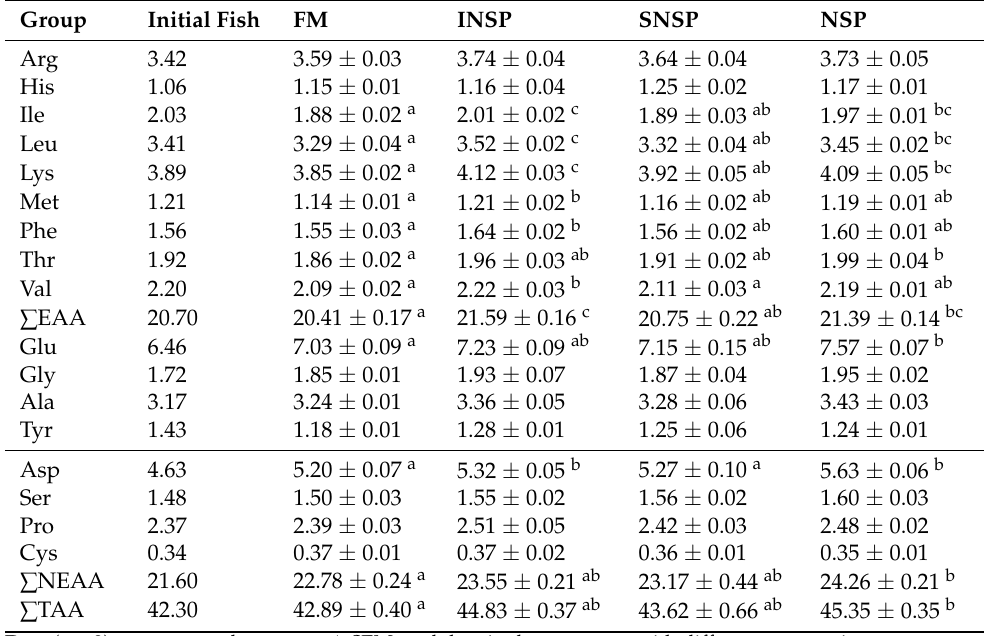
Table 7. Dorsal muscle amino acid profile of grass carp fed by test